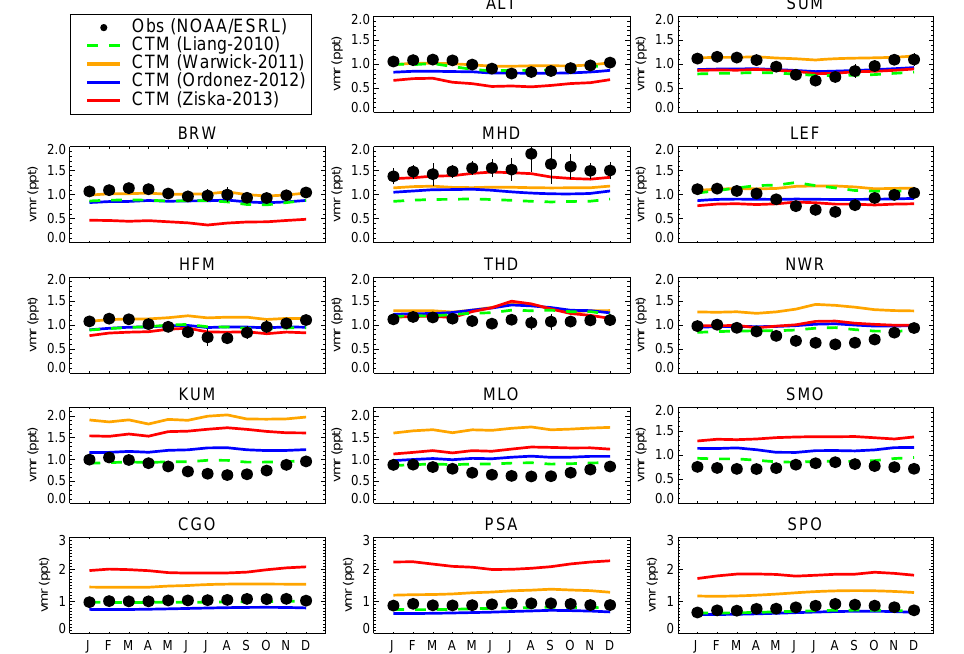
Fig. 6. As Fig. 5 but for CH 2 Br 2 .